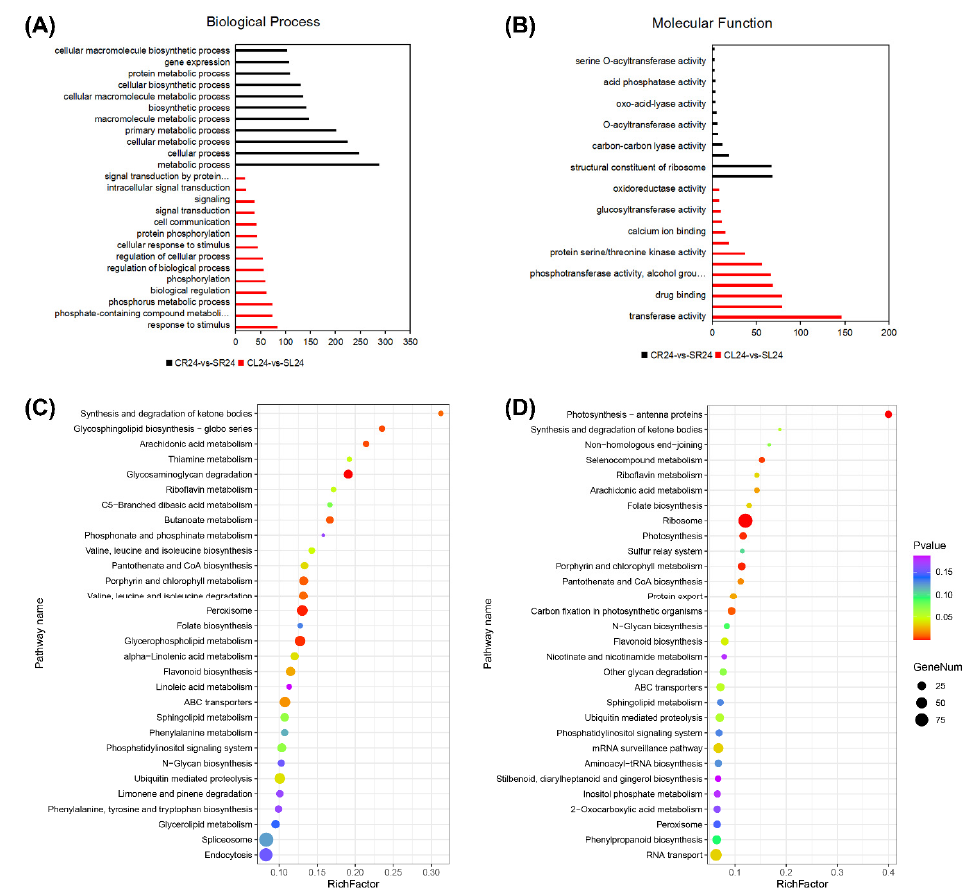
Figure 3. GO terms and KEGG pathways involved in the leaves and roots at 24 h in A. canescens under 100 mM NaCl treatment. ( A ) Biological process GO terms of CL24-vs-SL24 and CR24-vs-SR24. ( B ) Molecular function GO terms of CL24-vs-SL24 and CR24-vs-SR24. ( C ) Top 30 significantly enriched KEGG pathways in CL24-vs-SL24. ( D ) Top 30 significantly enriched KEGG pathways in CR24-vs-SR24. C and S represent the control conditions and 100 mM NaCl treatment, respectively; L and R denote the leaves and roots, respectively; and 24 denotes the treatment duration. The x-axis in ( A , B ) indicates the percentage of DEG numbers in each GO term; the x-axis in ( C , D ) indicates the percentage of DEG numbers vs. background gene numbers in each KEGG pathway.